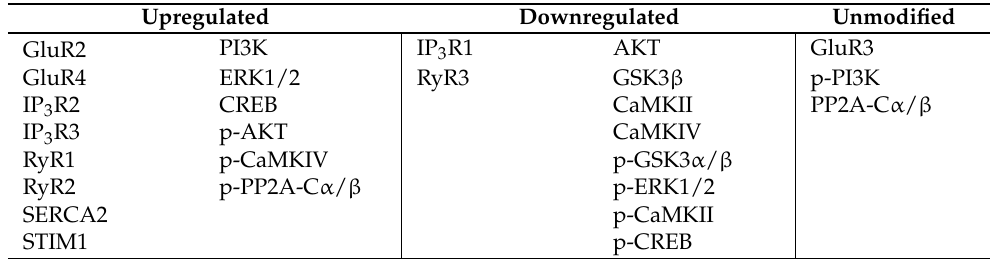
Table 1. Comparison of protein expression levels between SH-SY5Y/APP- cells and SH-SY5Y cells. AKT, Alternative appellation for Protein kinase B; CAMKII, Ca 2+ /calmodulin dependent kinase II; CAMKIV, Ca 2+ /calmodulin dependent kinase IV; CREB, cyclic AMP response element binding protein; ERK1/2, extracellular signal-regulated kinases 1/2; GluR, Glutamate receptor subunits; GSK3, glycogen synthase kinase-3; IP 3 R, Inositol 1,4,5-triphosphate receptor; PI3K, Phosphatidylinositol-3 kinase; PP2A-C α / β , Protein phosphatase 2A-C alpha/beta; RyR, Ryanodine receptor; SERCA2, Sarco/endoplasmic reticulum Ca 2+ -ATPase; STIM1, Stromal interaction molecule 1. Upregulated Downregulated Unmodified GluR2 PI3K IP 3 R1 AKT GluR3 GluR4 ERK1/2 RyR3 GSK3 β p-PI3K IP 3 R2 CREB CaMKII PP2A-C α / β IP 3 R3 p-AKT CaMKIV RyR1 p-CaMKIV p-GSK3 α / β RyR2 p-PP2A-C α / β p-ERK1/2 SERCA2 p-CaMKII STIM1